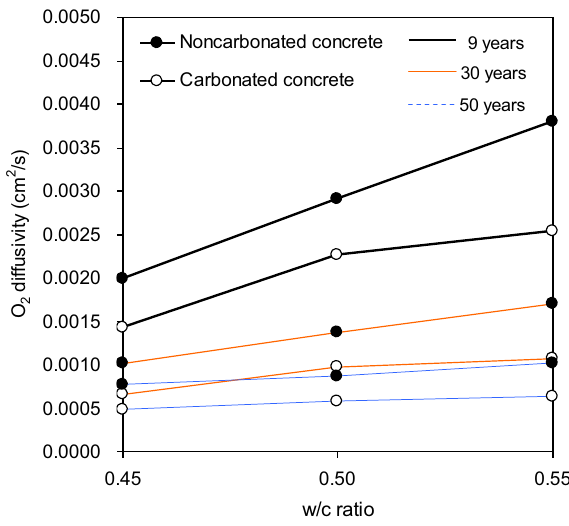
Fig. 9 Comparison of oxygen diffusivity of non-carbonated concrete and that of carbonated